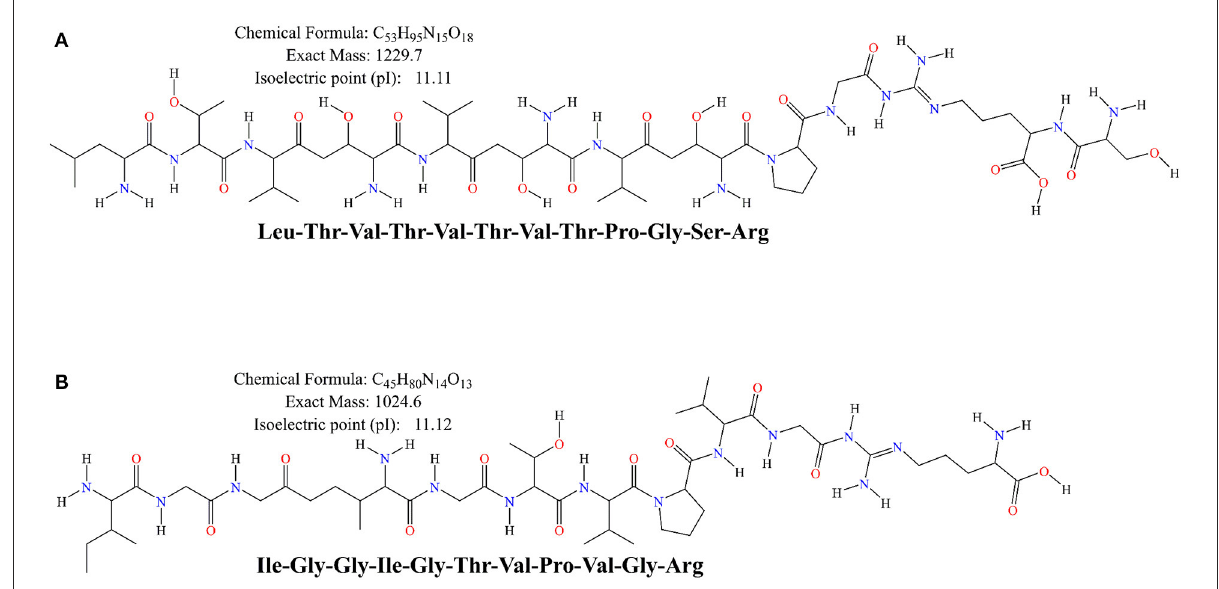
FIGURE5 The primary structure of the peptides LTVTVTVTPGSR (A) and IGGIGTVPVGR (B) was generated by ChemBioDraw Ultra (13.0)